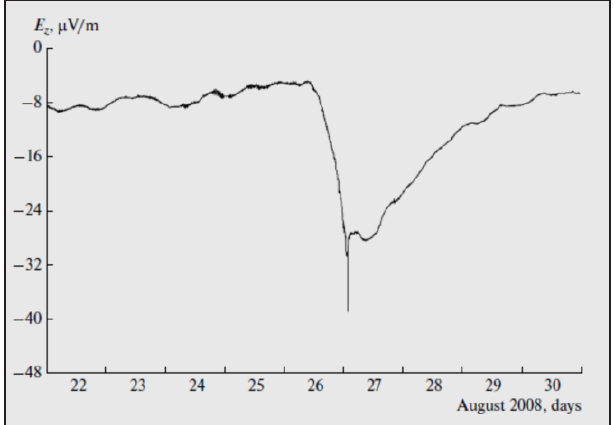
Figure 3. Change in the vertical component of electrical field (minutely averaged data) in August 2008, a few days before after the August 27 earthquake. The moment at which the earthquake occurred corresponds to the